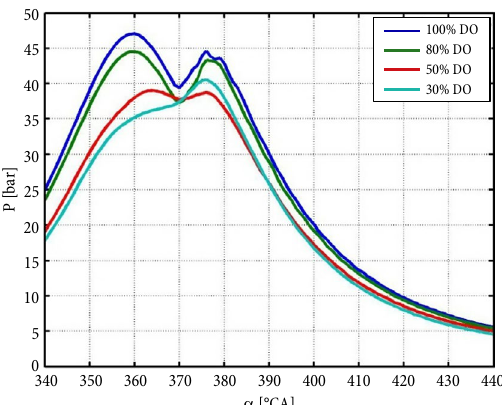
Fig. 5. Average recorded pressure versus CA for dual-fuel operation; n = 3400 rpm; T = 50 Nm (at different proportions of diesel